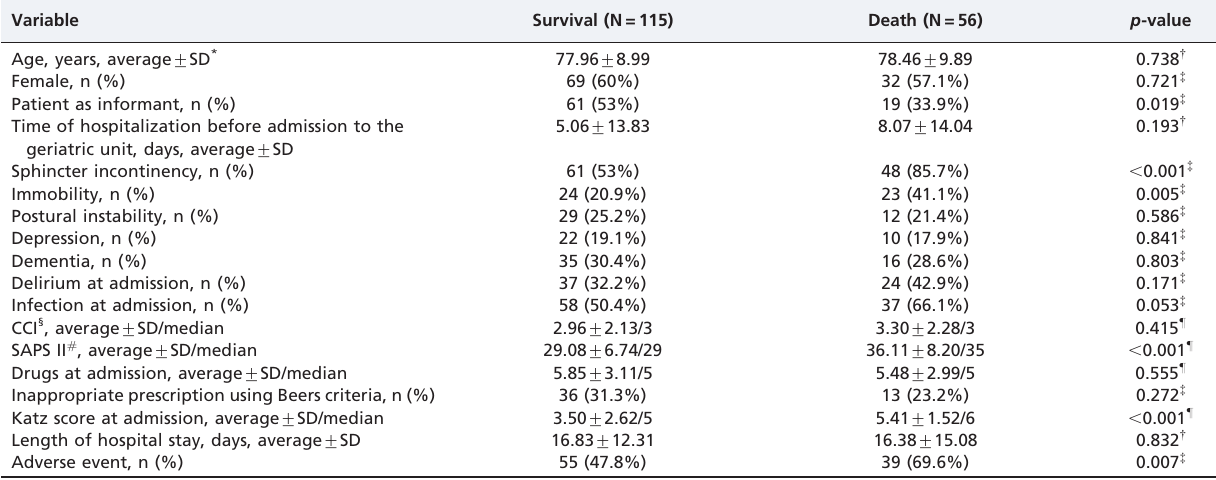
Table 3 - Univariate analysis of in-hospital predictors of